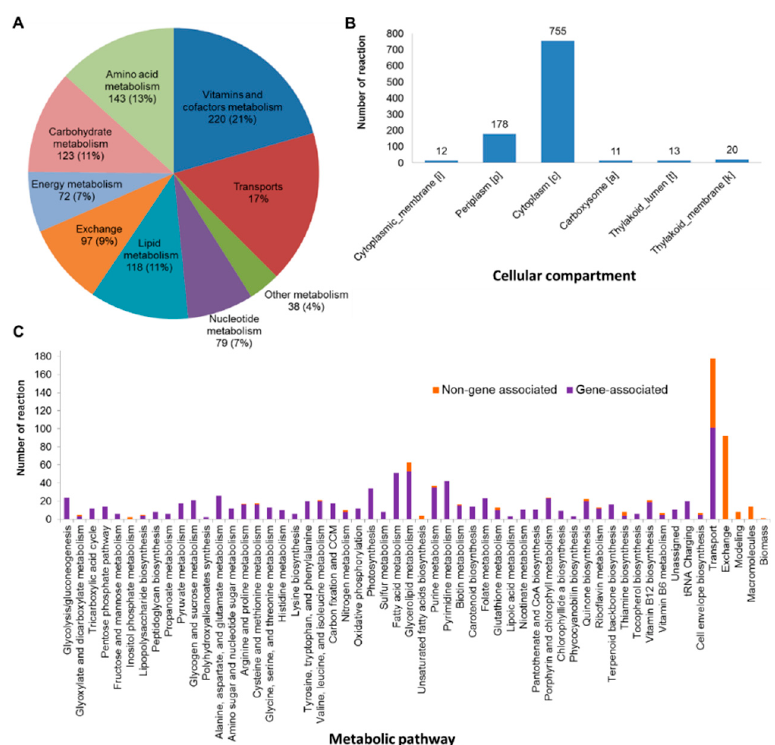
Figure 1. Properties of the updated genome-scale metabolic network of A. platensis C1. Distribution of reactions in each metabolism ( A ), Distribution of reactions in each cellular compartment ( B ), Gene associated and non-gene associated reaction in each metabolic pathway ( C ).